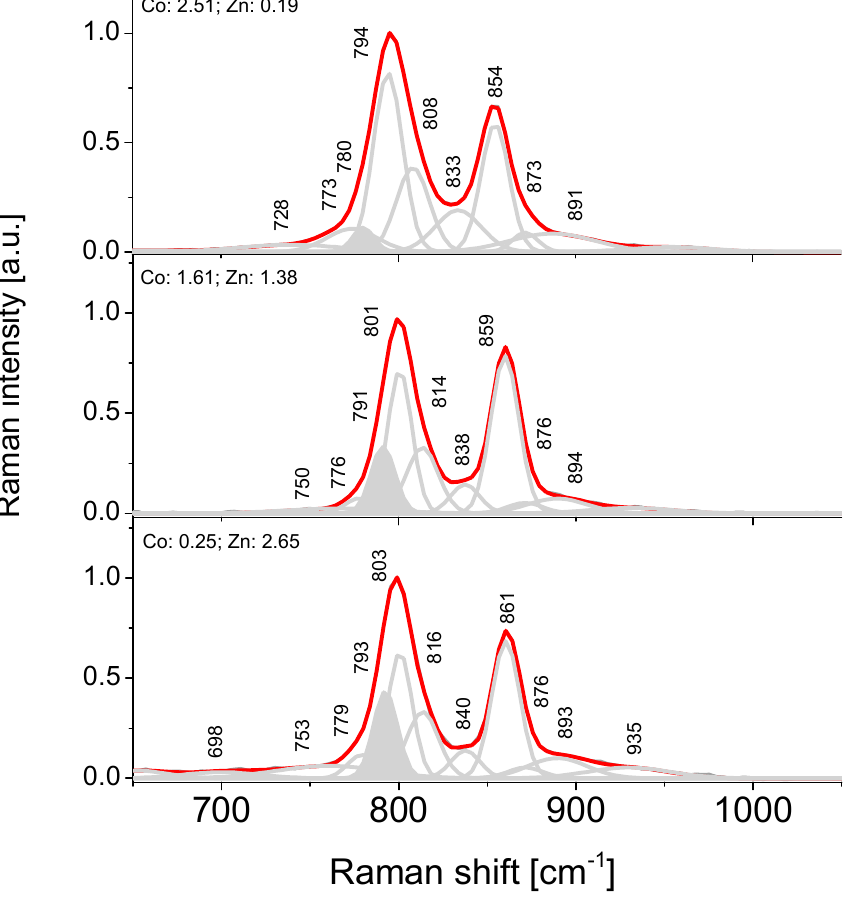
Figure 9. Fitted Raman spectra of members of the erythrite–köttigite solid solution in the region of stretching vibrations of [AsO 4 ]. Shaded band in each spectrum corresponds to the vibrations of [(Co,Zn)O 6 ]. Changes in the band intensity correlate well with the Co ↔ Zn isomorphic substitutions. The Raman spectrum below 500 cm –1 is complex due to the multitude of overlapping bands which are difficult to assign to particular vibrational modes (Figure 10). It is, however, possible to − 1 distinguish a region of ν 4 and ν 2 deformation modes of [AsO 4 ] tetrahedra in the range 500–400 cm − 1 − 1 and 400–250 cm from the lattice modes below 250 cm (Figure 10). This observation is in agreement with previously published data for erythrite [10,14,26]. The occurrence of a HAsO 4 group in erythrite − 1 may activate a deformational type of vibration at 374 and 344 cm [32]. Substitution of Co by Zn − 1 causes these bands to shift to 378 and 336 cm , respectively (Figure